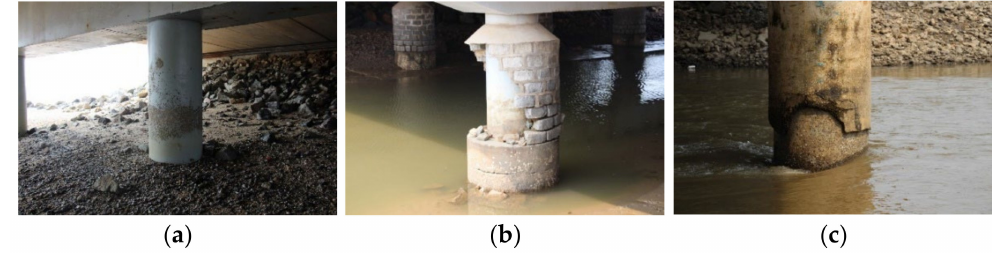
Figure 1. Damage forms of pre-installed anti-freezing measures. ( a ) Coating paint. ( b ) Stacking stone brick. ( c ) Wrapping foam asbestos net.